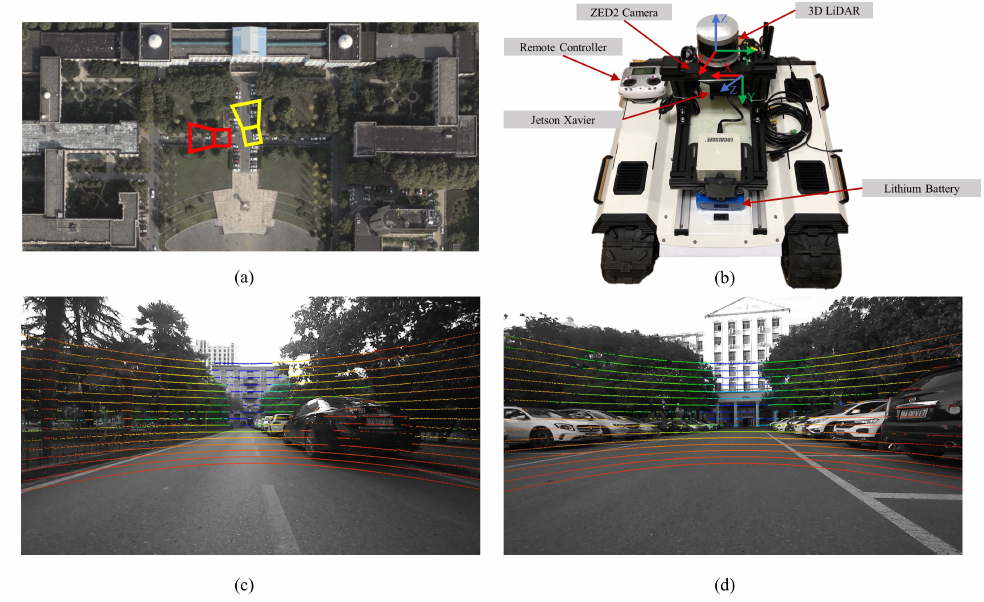
Figure 17. Data recording platform and corresponding collection environment. ( a ) data collection environment; ( b ) data collection platform; ( c , d ) are sample data collected at red and yellow box respectively showed in ( a ) , the points are color-coded by their depth